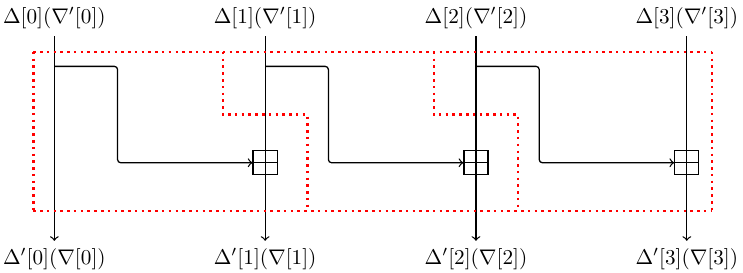
Figure 8: A simplified 1-round switch of LEA. (The symbols for the backward direction are given in the